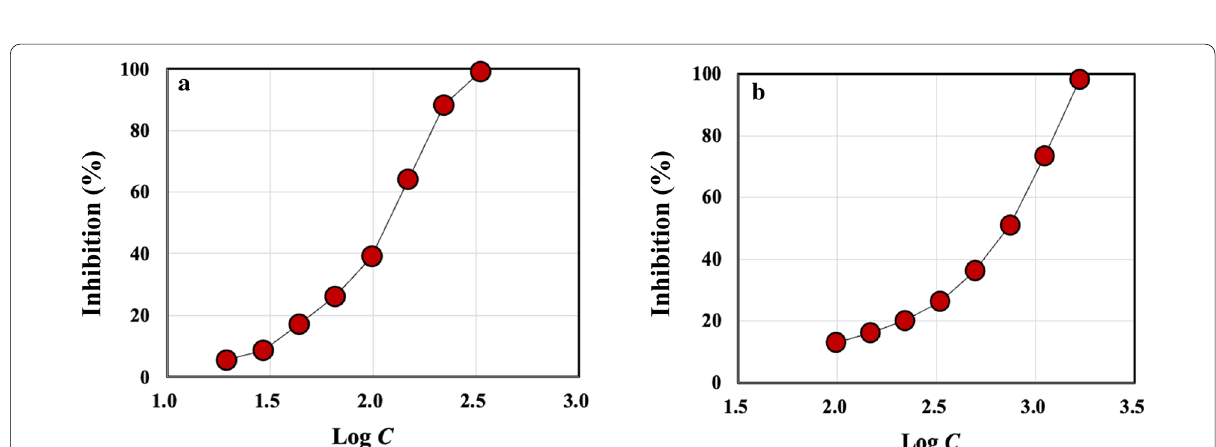
Fig. 4 The inhibitions of the hydroxyl radical by a Trolox and b CPH II in percentage as a function of logarithm of the CPH II concentration, C in